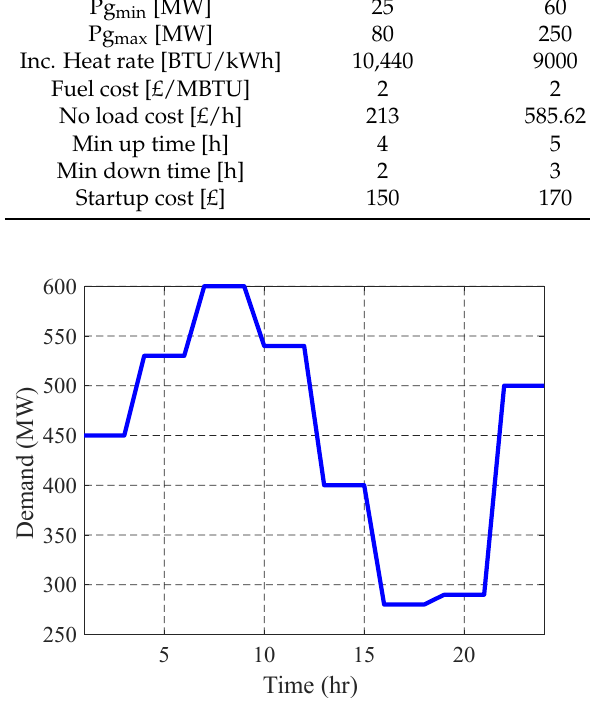
Table 3. Case 1—test system data.